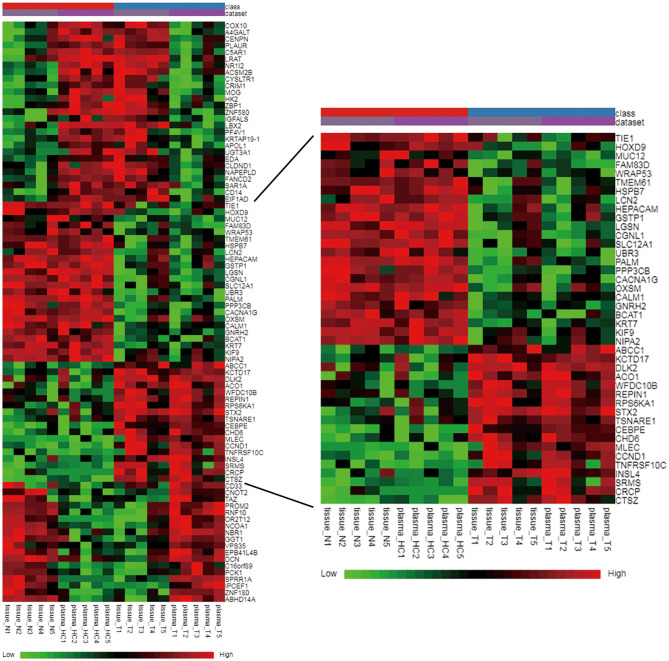
Hierarchical clustering heat map of the common differently expressed mRNAs between E-MTAB-1830 and our datasets. Green color: low expression; black color: moderate expression; red color: high expression.